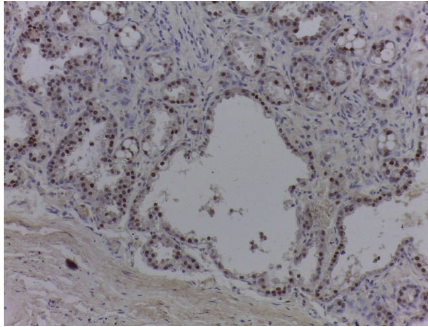
Figure 4: ( × 400) Ductal cells with strong estrogen receptor positiv- ity.